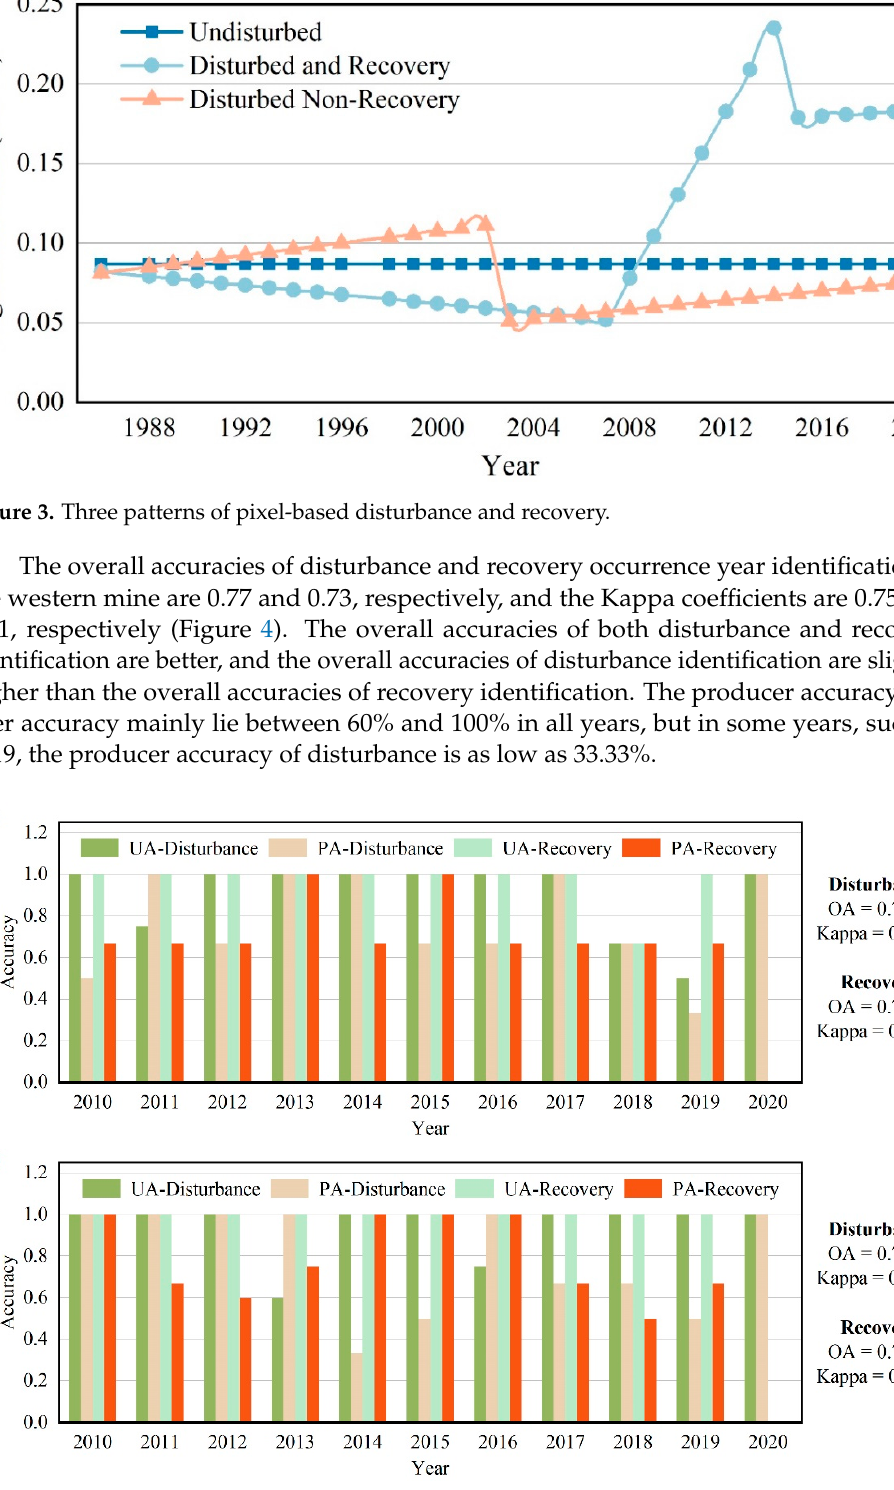
2020: UA: user accuracy; PA: producer accuracy; OA: overall accuracy. ( a ) the western mine; ( b ) the